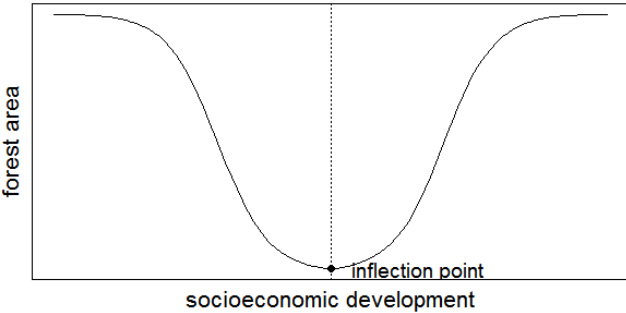
Figure 2. Sketch map of the forest transition curve.